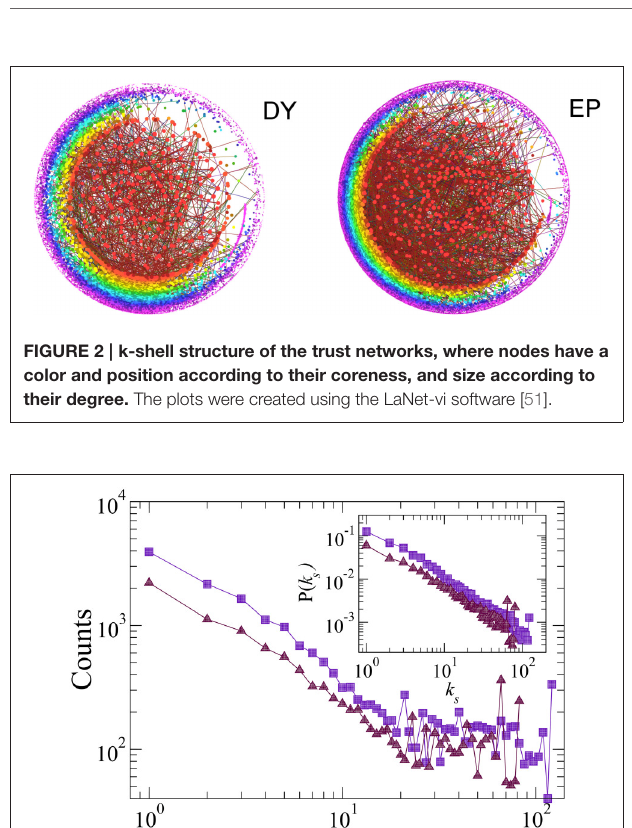
than three times the LCC of the DY) the number of users in the more central k-shells is similar in both networks. This means that the number of very central users is not directly proportional to the total amount of users in a network, thus, there should be other factors determining users’